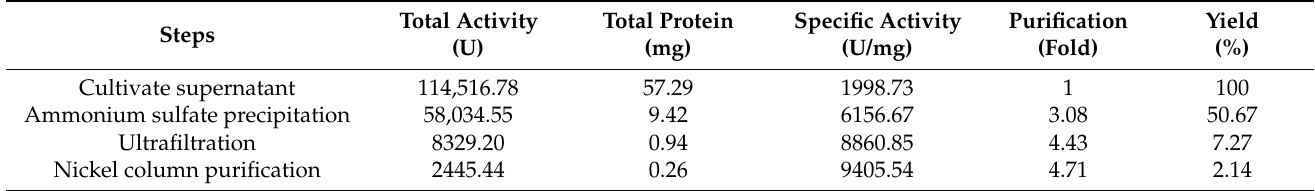
Table 2. Purification of collagenase from B. subtillis WB600/pP43NMK- col .